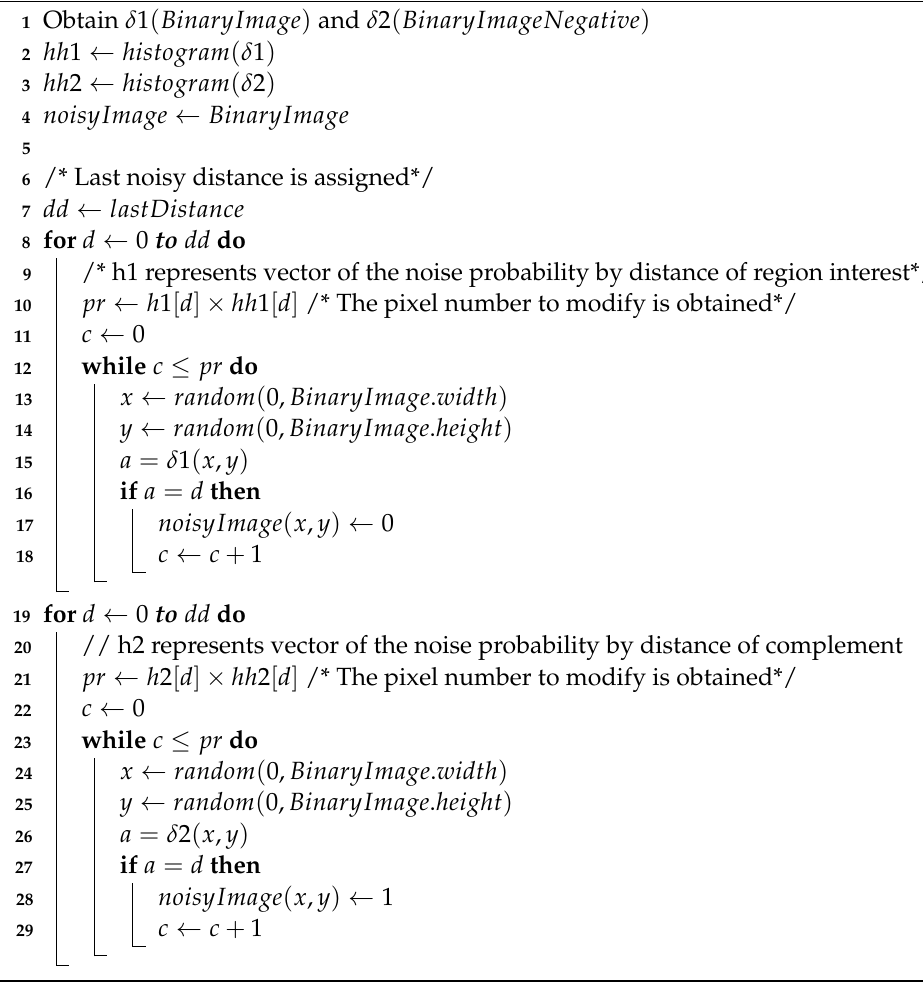
Figure 9. Noise scheme. Algorithm 4 Mixed noise simulation algorithm for binary